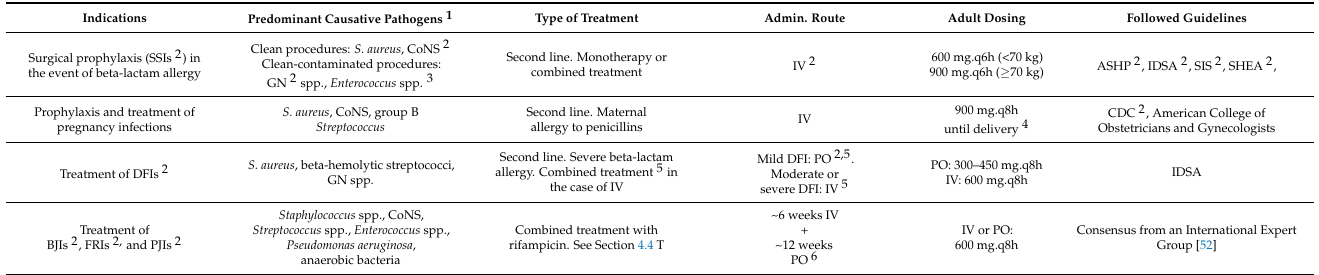
Table 5. Clinical practice and efficacy indications for clindamycin, concerning prophylaxis and treatment of systemic bacterial